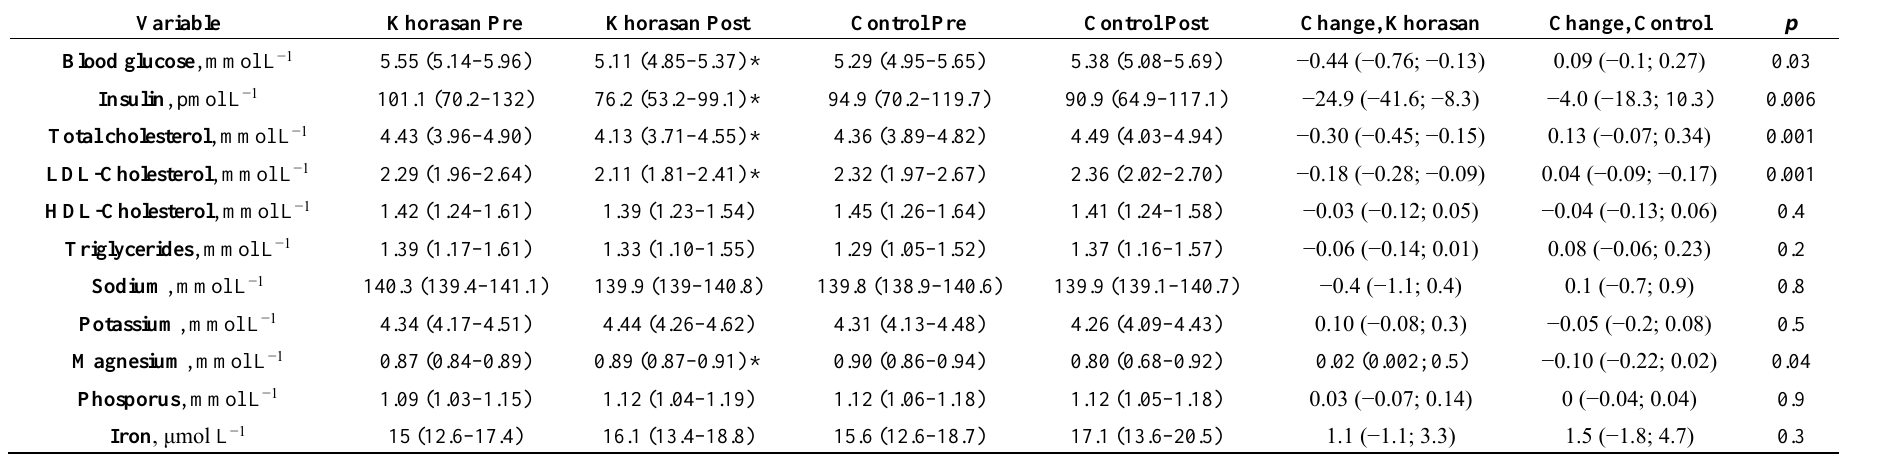
Table 2. Modifications in biochemical parameters a .